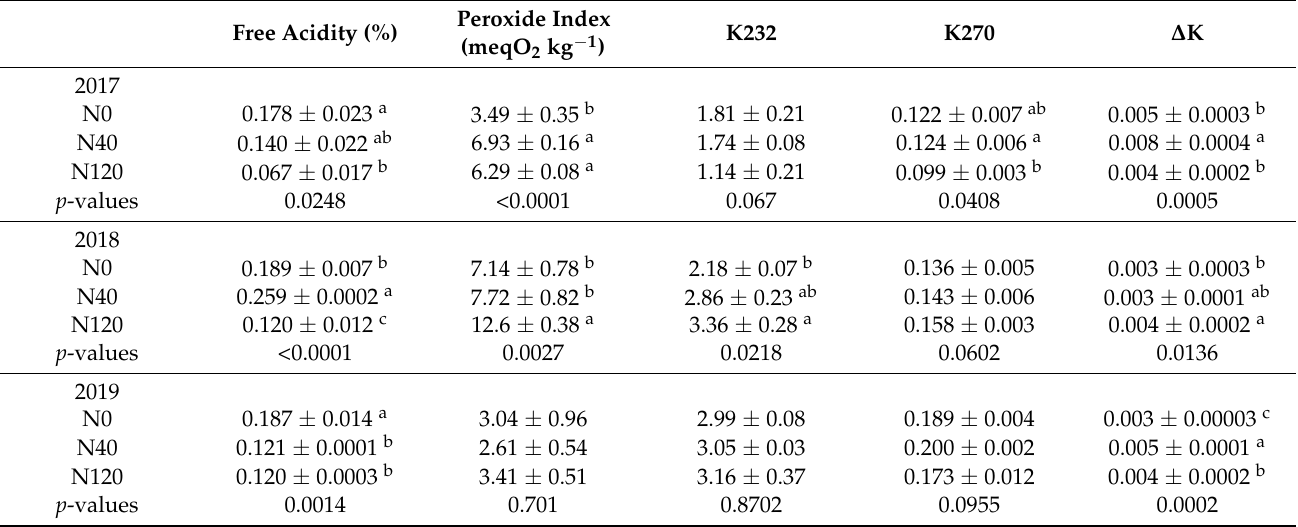
Olive oil quality indices from olive of trees supplied with 0 (N0), 40 (N40)